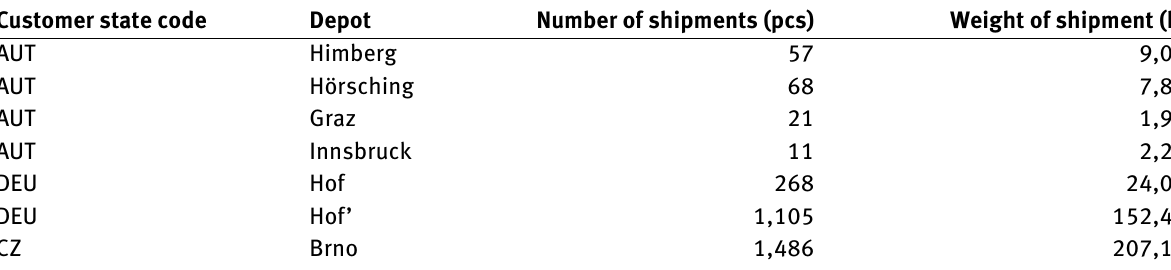
Table 2: The minimum distance matrix of the selected set of vertices km Himberg Hörsching Graz Innsbruck Himberg